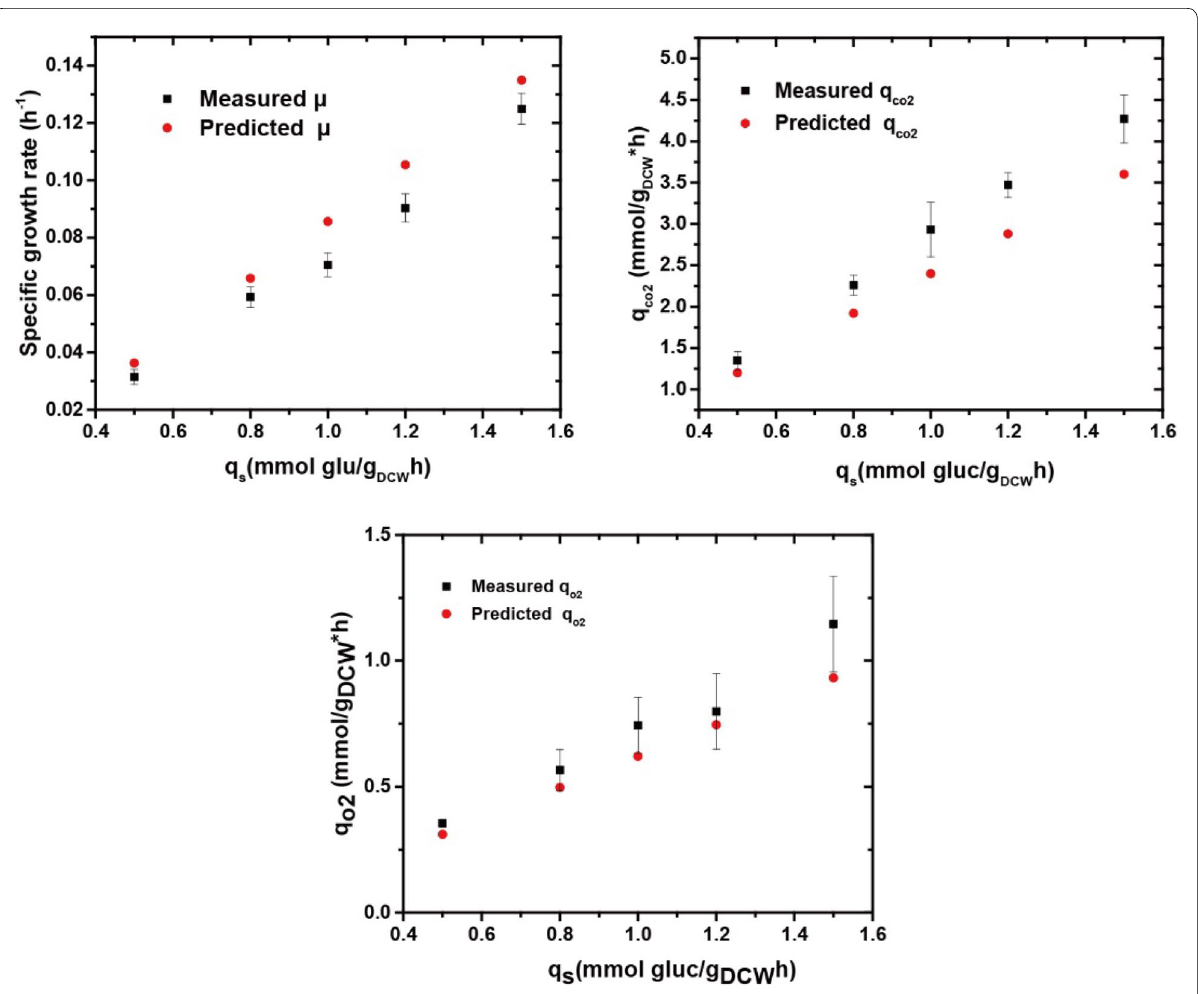
Fig. 4 The result of the predicted and measured μ , q O2 , and q CO2 for chemostat cultivation of S. erythraea NRRL23338. The NGAM used in simulation was 3 mmol ATP/gDCW h. Black represents simulated results of the GEMs iZZ1342, and red 13 represents the experimental data from our